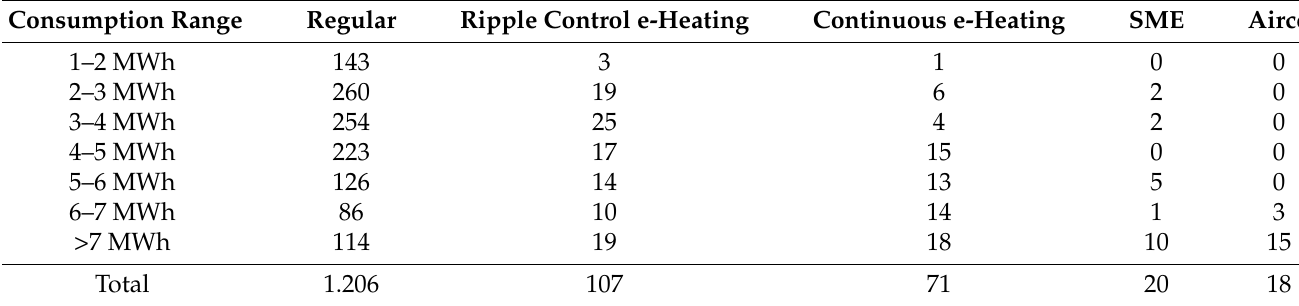
Table 1. Dataset composition by the defined profile categories, by consumption